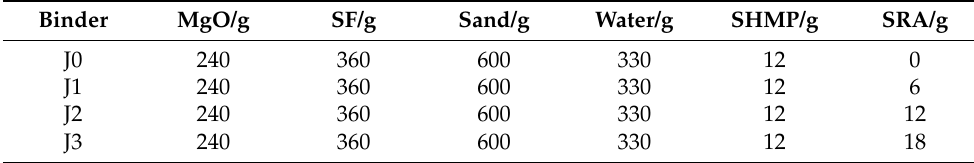
Table 2. Mix proportion of M-S-H